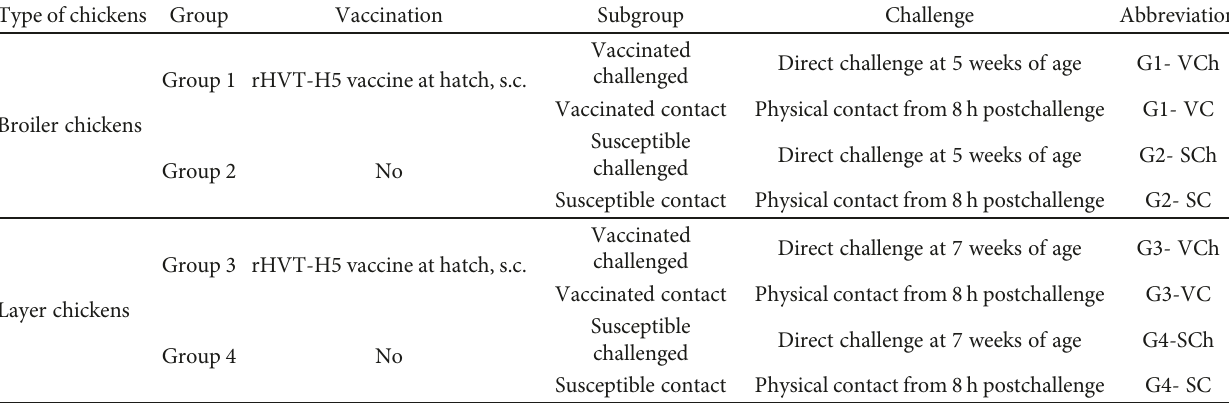
Table 1: Summary of the two transmission experiments set